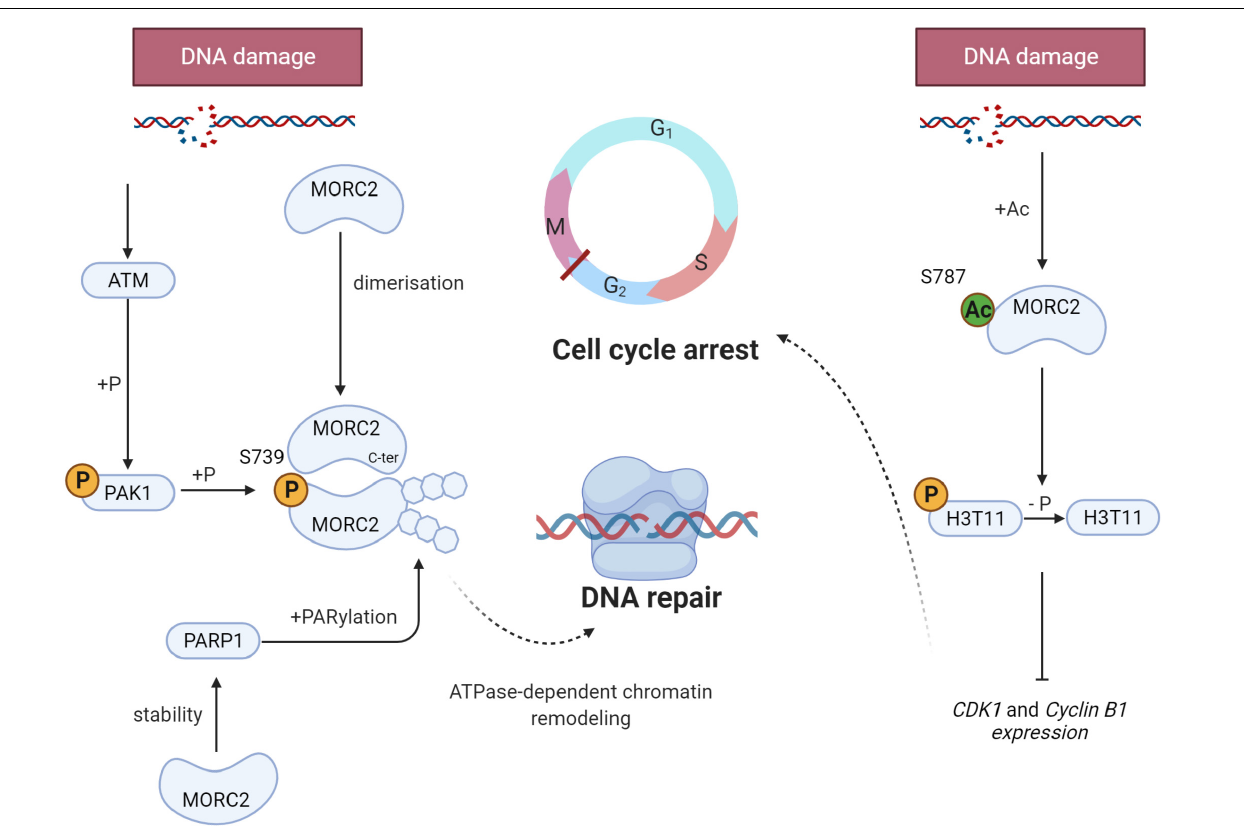
FIGURE 5 | Schematic representation of the key role of MORC2 in the DNA Damage Response (DDR). When DNA damage occurs, MORC2 undergoes several post translational modifications (on the left side) : Serine 739 phosphorylation through ATM/PAK1 pathway, dimerization and PARylation. All modifications allow ATPase-dependent chromatin remodeling and thus enable efficient DNA damage repair. MORC2 can also be acetylated on serine 787 favoring its interaction with the phosphorylation of histone H3 threonine 11 (H3T11P). This will lead to H3T11P dephosphorylation and CDK1 and cyclin B1 repression. G2/M checkpoint will be activated and promotes cell cycle